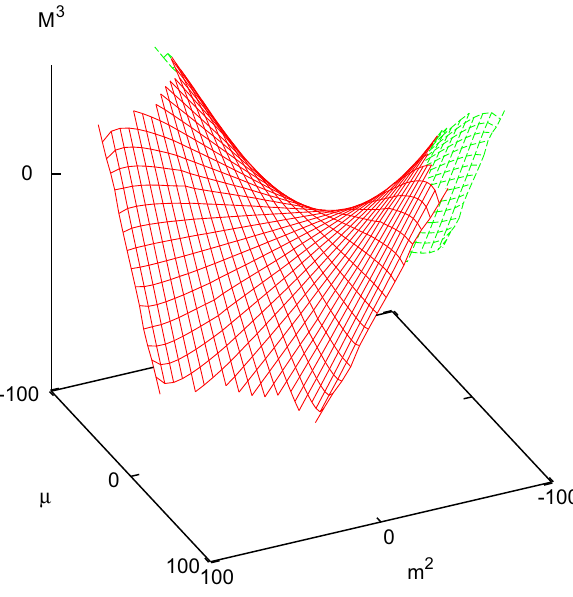
Fig. 1 A two-dimensional surface in the space of parameters where the topological invariant is N 3 = 0, but any small perturbation will give a nonzero result. In this case, the phase boundary is characterized by the equation M 3 + m 2 μ = 0